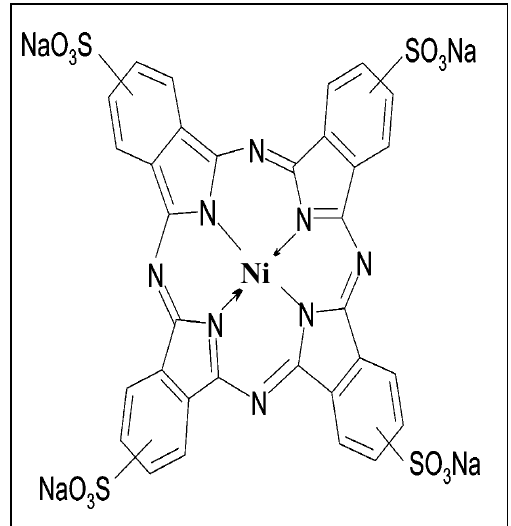
Fig. 1: Molecular structure of nickel (ii) phthalocyanine tetrasulfonic acid tetrasodium salt (NiTsPc z)